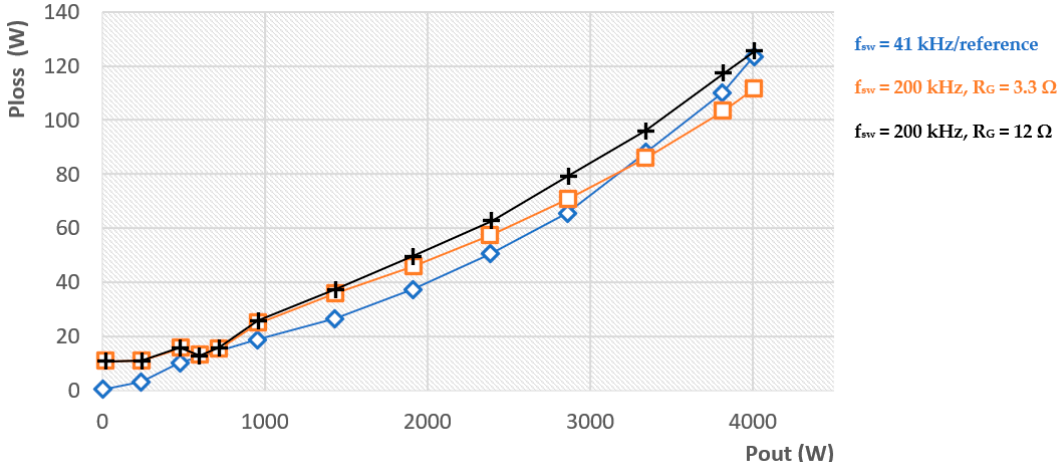
Figure 14. Power losses of PFC converter equipped with IMZA65R072M1 SiC transistor in dependency on the output power and switching frequency (blue line—referenced non-optimized solution).